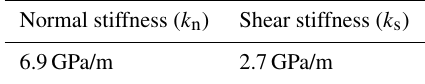
Table 2. Elastic mechanical properties of typical rock joints in Ur- gonian